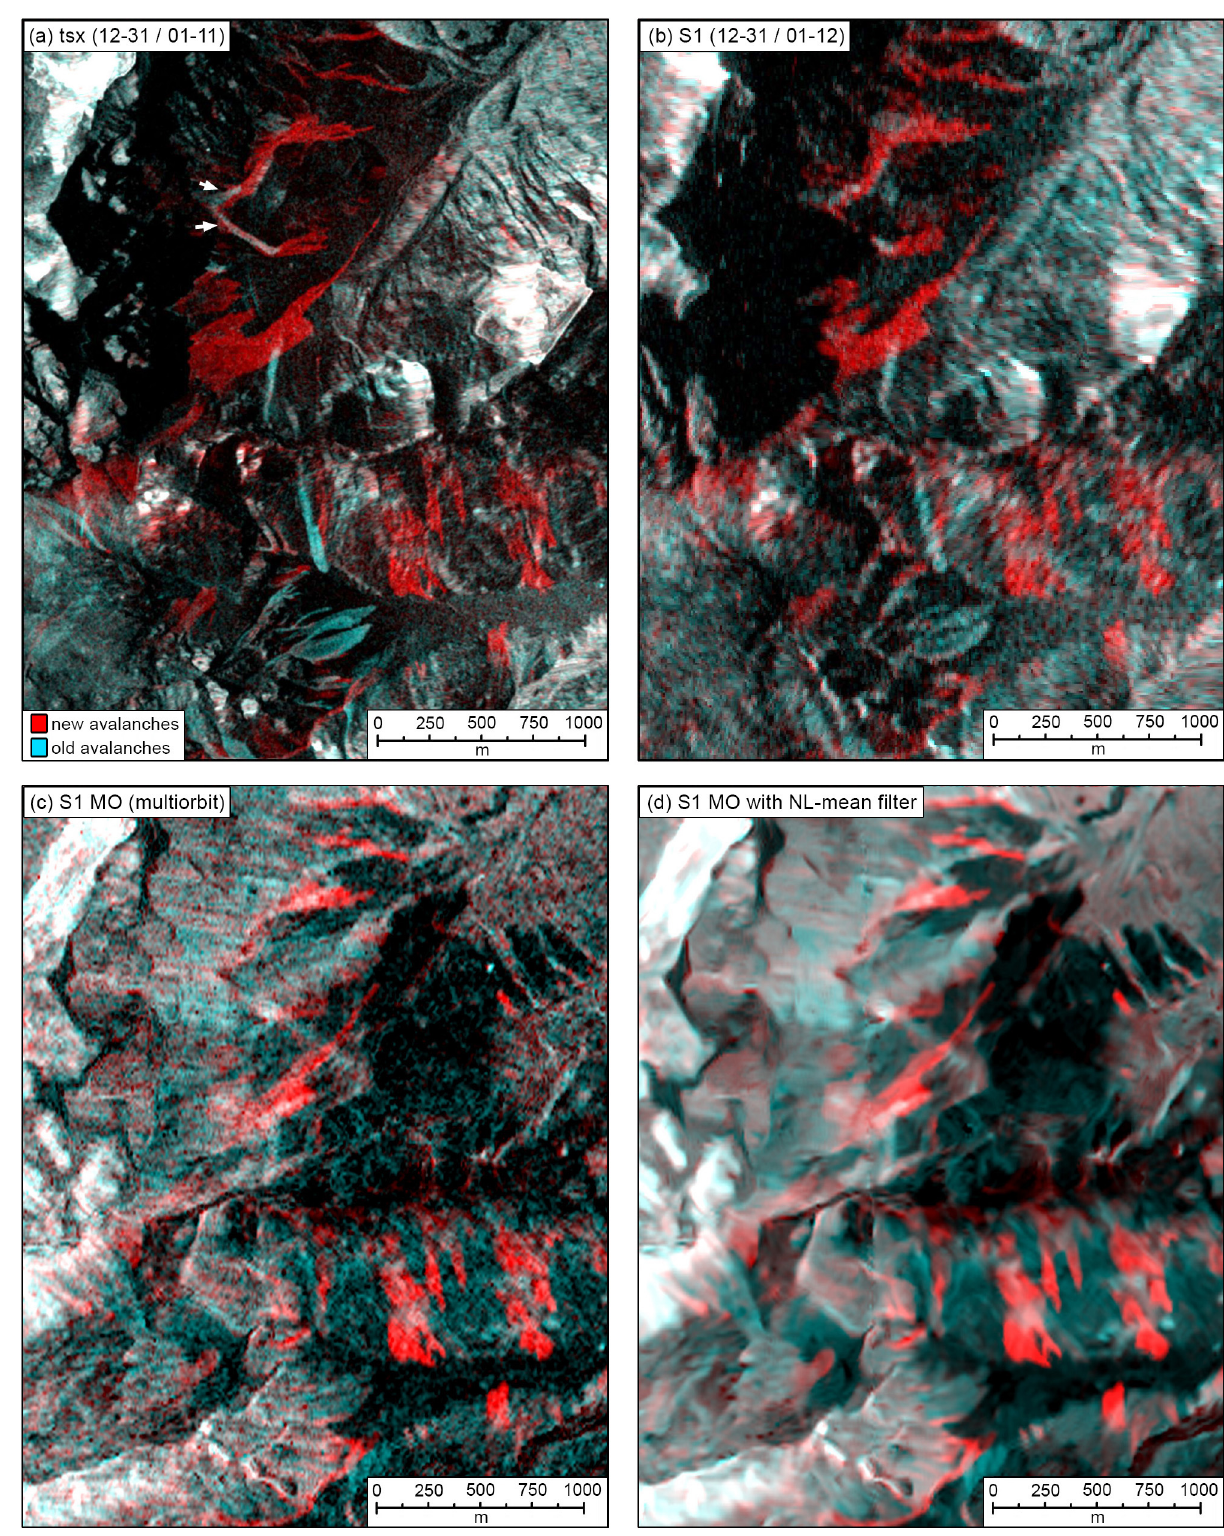
Figure 4. Subsets of the change detection images of the study area from (a) TSX and (b) S1, acquired with ascending orbits (view from left to right) and incidence angles of 29 and 34 ◦ . Arrows in (a) indicate old avalanches overrun by new ones. (c) S1 multiorbital composite (28 December 2017–1 January 2018 vs. 9–12 January 2018) with (d) nonlocal mean filter applied. All TerraSAR-X and Copernicus Sen- tinel data (2019) were orthorectified with the swissALTI3D © 2019 swisstopo (JD100042), reproduced with the authorization of swisstopo